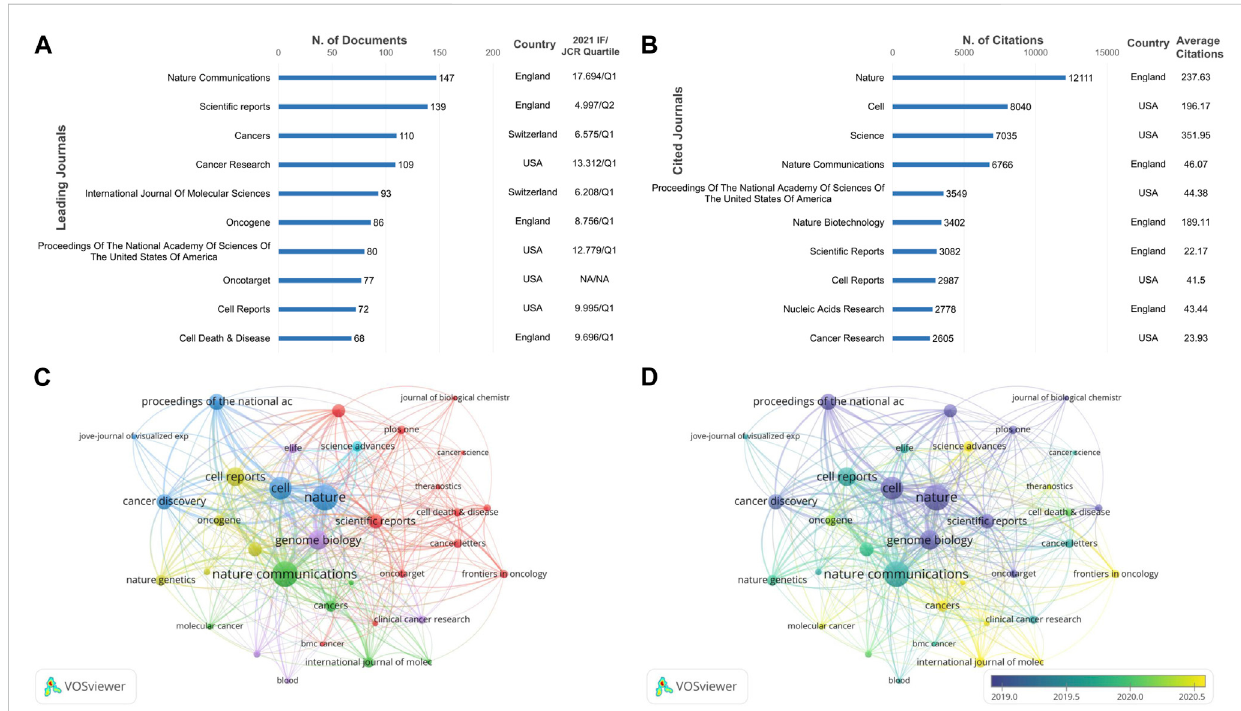
FIGURE 4 Bibliometric analysis of leading journals on CRISPR in cancer. (A) The top 10 published journals. (B) The top 10 cited journals. (C) Network visualization map of the leading journals. (D) Overlay visualization map of the leading journals.